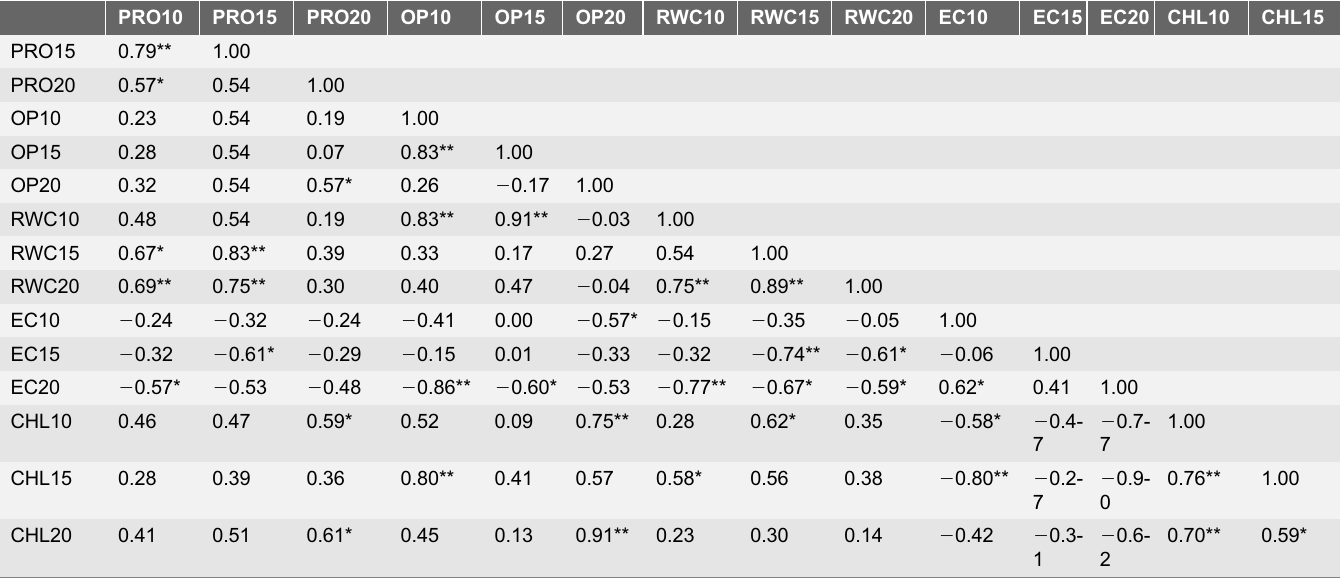
Table 1. Correlation coefficient (r) between the different physio-biochemical parameters under various concentration of PEG after 3 days of